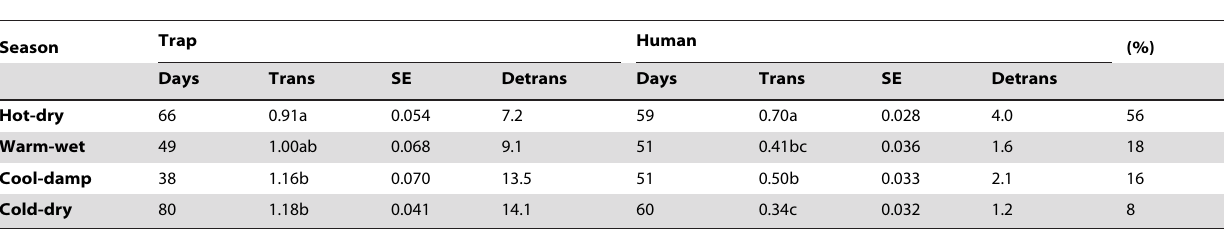
Table 3. Catches of G. m. morsitan s from traps and humans.